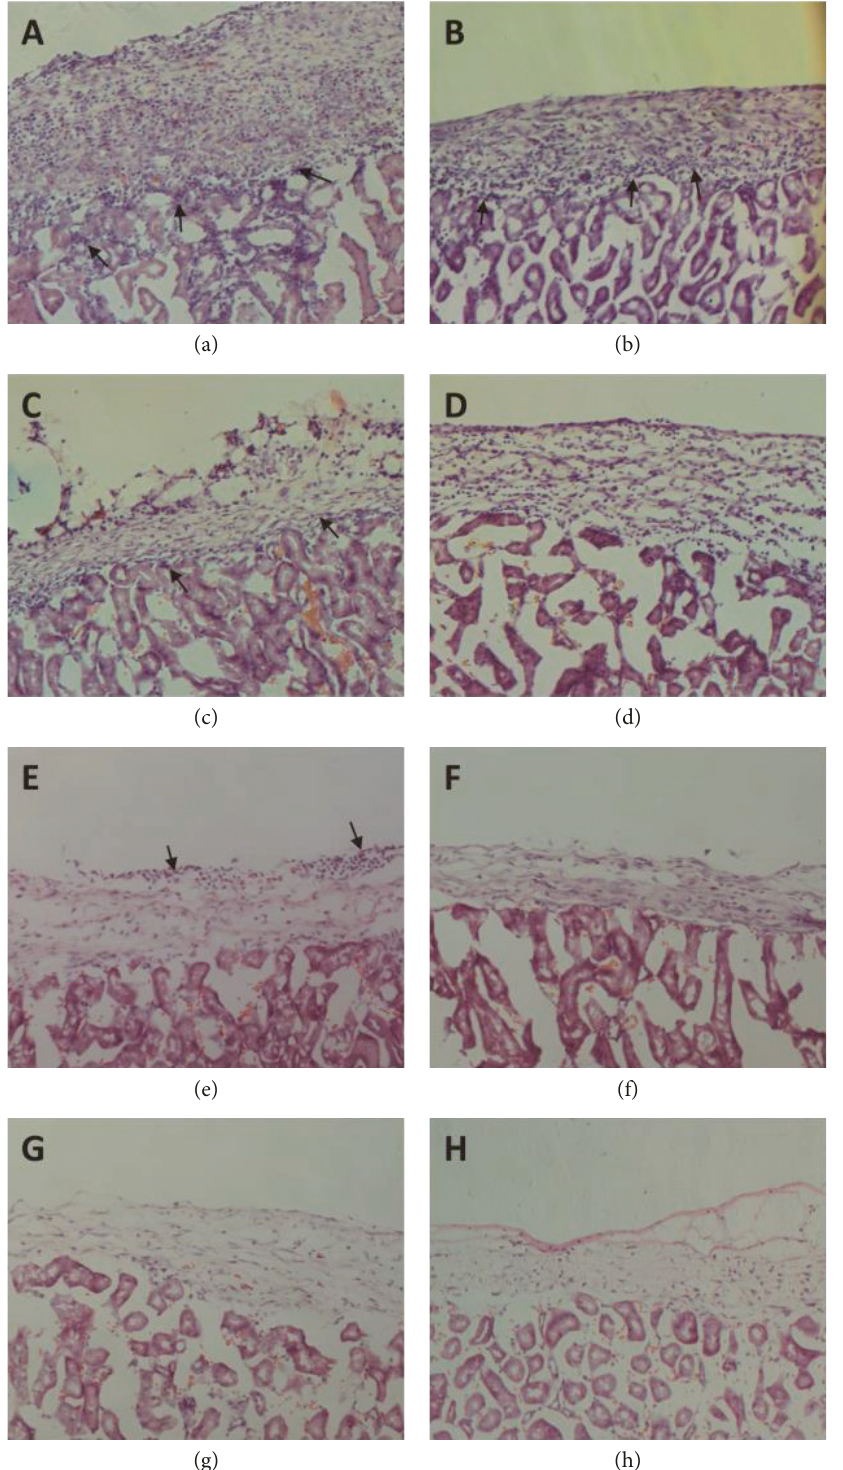
Figure 4: Lymphocytic in fi ltration analysis of the graft-bearing kidneys at di ff erent time periods stained with hematoxylin and eosin. Allogeneic MSC and allogeneic+preactivated MSCs (b) after 7 days post transplantation. Allogeneic MSC (c) and allogeneic +preactivated MSCs (d) after 14 days post transplantation. Allogeneic MSC (e) and allogeneic +preactivated MSCs (f) 28 days post transplantation. Syngeneic MSC (g) 28 days post transplantation and syngeneic MSC (h) 100 days post transplantation. Magni fi cation of